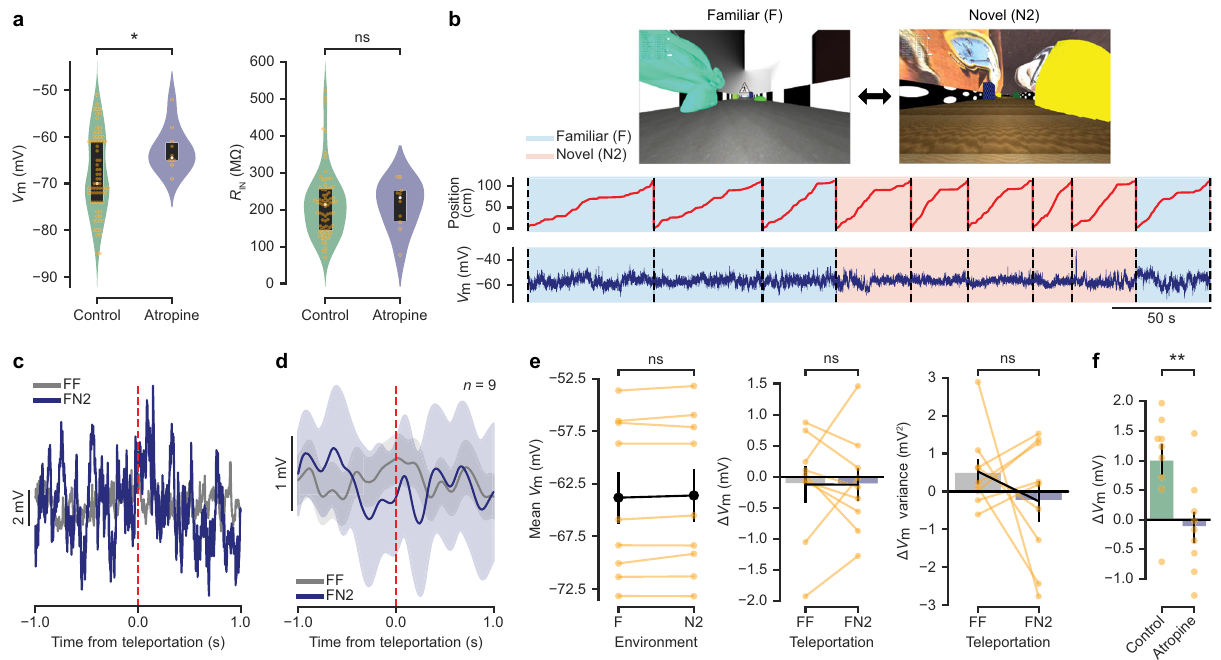
Fig. 4 Atropine abolishes the V m response to saliency in granule cells. a Left: membrane potential ( V m ) in granule cells under control conditions and after local injection of atropine (control: − 68 ± 1 mV, median = − 70 mV, 1st and 3rd quartiles = − 74 and − 61 mV, n = 73 cells; atropine: − 63 ± 2 mV, median = − 64.5 mV, 1st and 3rd quartiles = − 65.0 and − 61.3 mV, n = 10 cells; two-sided Mann – Whitney U test, U = 224.5, p = 0.03). Right: input resistance ( R IN ) in granule cells under control conditions and after local injection of atropine (control: 216 ± 11 M Ω , median = 214 M Ω , 1st and 3rd quartiles = 146 M Ω and 255 M Ω , n = 73 cells; atropine: 211 ± 21 M Ω , median = 232 M Ω , 1st and 3rd quartiles = 170 and 250 M Ω , n = 8 cells; two-sided Mann- Whitney U test, U = 331.0, p = 0.3). Box plots represent median and 1st and 3rd quartiles. b Example recording under atropine. Data presented as in Fig. 2b. c Teleportation-aligned average from a representative recording under atropine. Data presented as in Fig. 2c. d Teleportation-aligned average across multiple recordings under atropine ( n = 9 cells). Data presented as in Fig. 2d. e Left: Summary of mean V m for familiar (F) and novel (N2) environments after local injection of atropine ( − 63.8 ± 2.5 mV mV and − 63.6 ± 2.5 mV, respectively; n = 9 cells, two-sided Wilcoxon signed-rank test, T = 12.0, p = 0.2). Middle: Summary of Δ V m for teleportations within F (FF) and teleportations from F to N2 (FN2) ( − 0.13 ± 0.29 mV and − 0.13 ± 0.27 mV, respectively; n = 9 cells, two-sided Wilcoxon signed-rank test, T = 22.0, p = 1.0). Right: Δ V m variance summary for FF and FN2 teleportations (0.5 ± 0.3 mV 2 and − 0.3 ± 0.5 mV 2 , respectively; n = 9 cells, two-sided Wilcoxon signed-rank test, T = 16.0, p = 0.4). f Summary of Δ V m for FN2 teleportations under control conditions and after local injection of atropine (control, n = 9 cells versus atropine, n = 9 cells; two-sided Mann – Whitney U test, U = 13.0, p = 0.009). Left bar: same data as in Fig. 2e middle, right bar. Right bar: same data as in e middle, right bar. Data are presented as the mean ± s.e.m. Source data are provided as a Source Data fi le. See also Supplementary Fig.